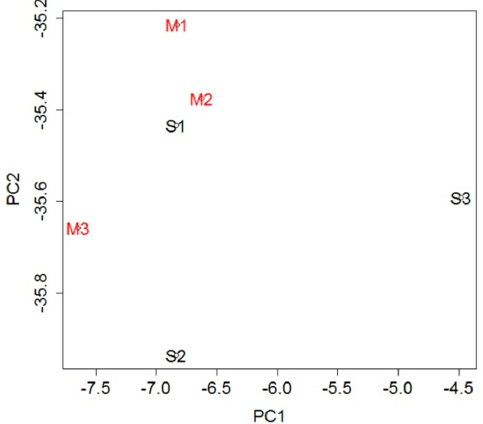
Figure 2. Principal component analysis (PCA) using expression levels of all probe sets. The general clustering of the samples within each group indicates the difference between the groups.